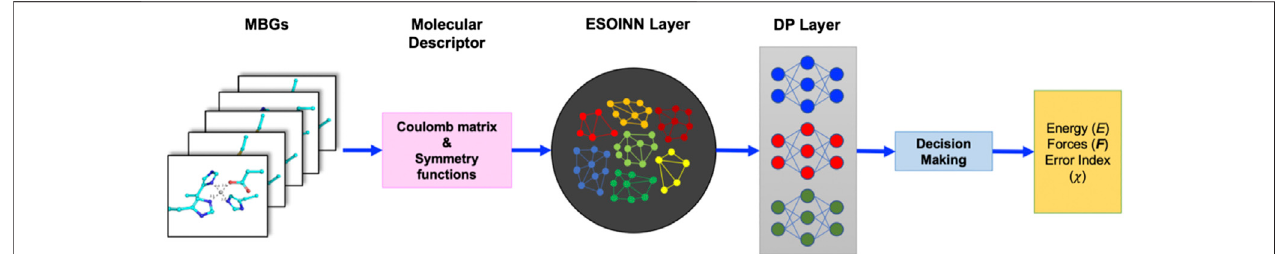
FIGURE 2 | Framework of the ESOINN-DP method.